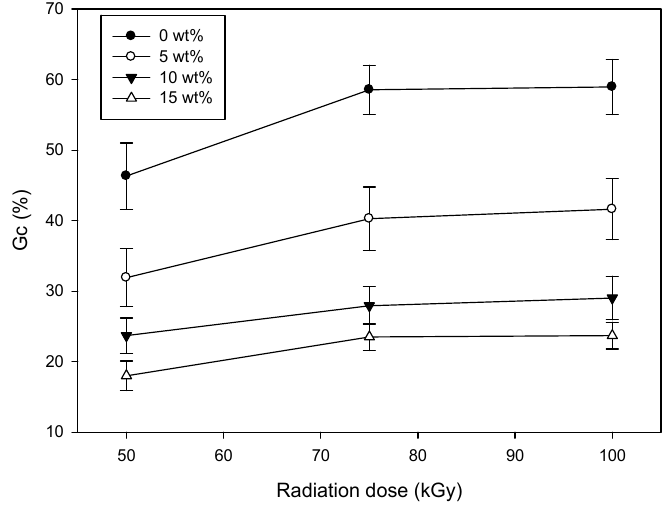
Figure 2. Variation of G c with different content of honey in CH–CMC hydrogels.